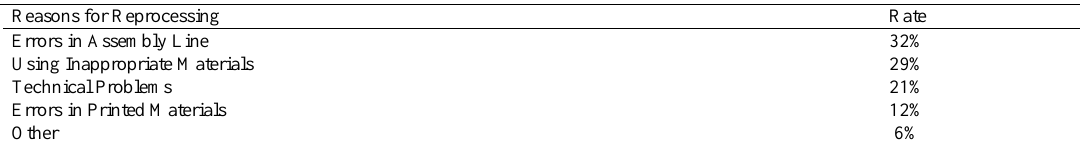
Table 7. Reasons for reprocessing the packaged